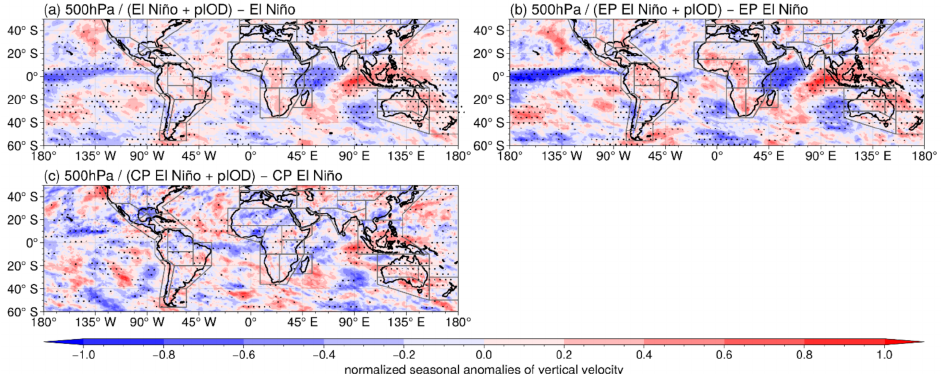
Figure 11. Normalized seasonal anomalies of vertical velocity in SON when combined El Niño and pIOD occur. ( a ) is for El Nino, ( b ) is for EP El Nino, and ( c ) is for CP El Nino. (El Niño + pIOD) − El Niño represents the difference between the vertical velocity anomalies when combined events occur and the frequency when only El Niño events occur. The dotted areas are significant at the 95% confidence